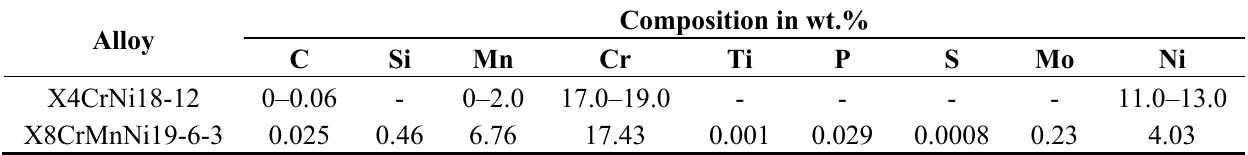
Table 1. Chemical compositions of the processed austenitic steels X4CrNi18-12 and